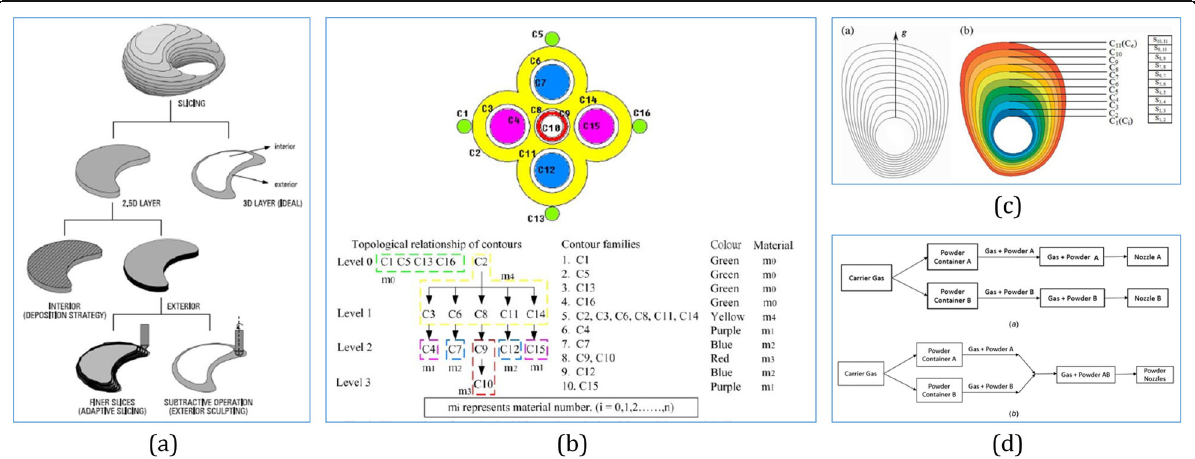
Fig. 13 a General process planning in additive manufacturing [122]. b Illustration of topological hierarchy relationship of multi-material slice contours [123]. c EDO approach for the representation of sub-regional FGMs and then plan toolpath for fabricating [124]. d Two AM-based schemes for heterogeneous objects with FGMs